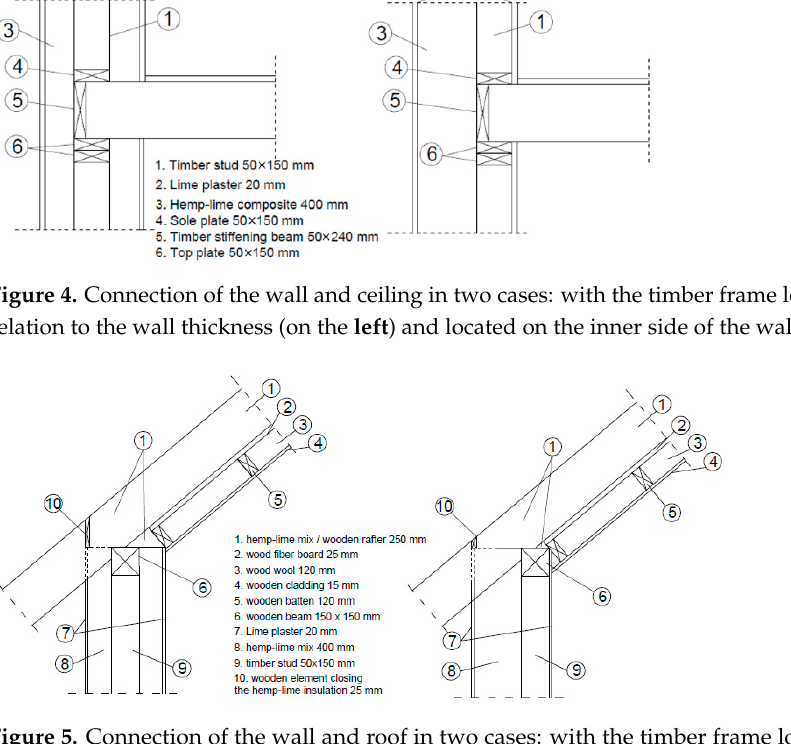
Figure 5. Connection of the wall and roof in two cases: with the timber frame located centrally in relation to the wall thickness (on the left ) and located on the inner side of the wall (on the right ).